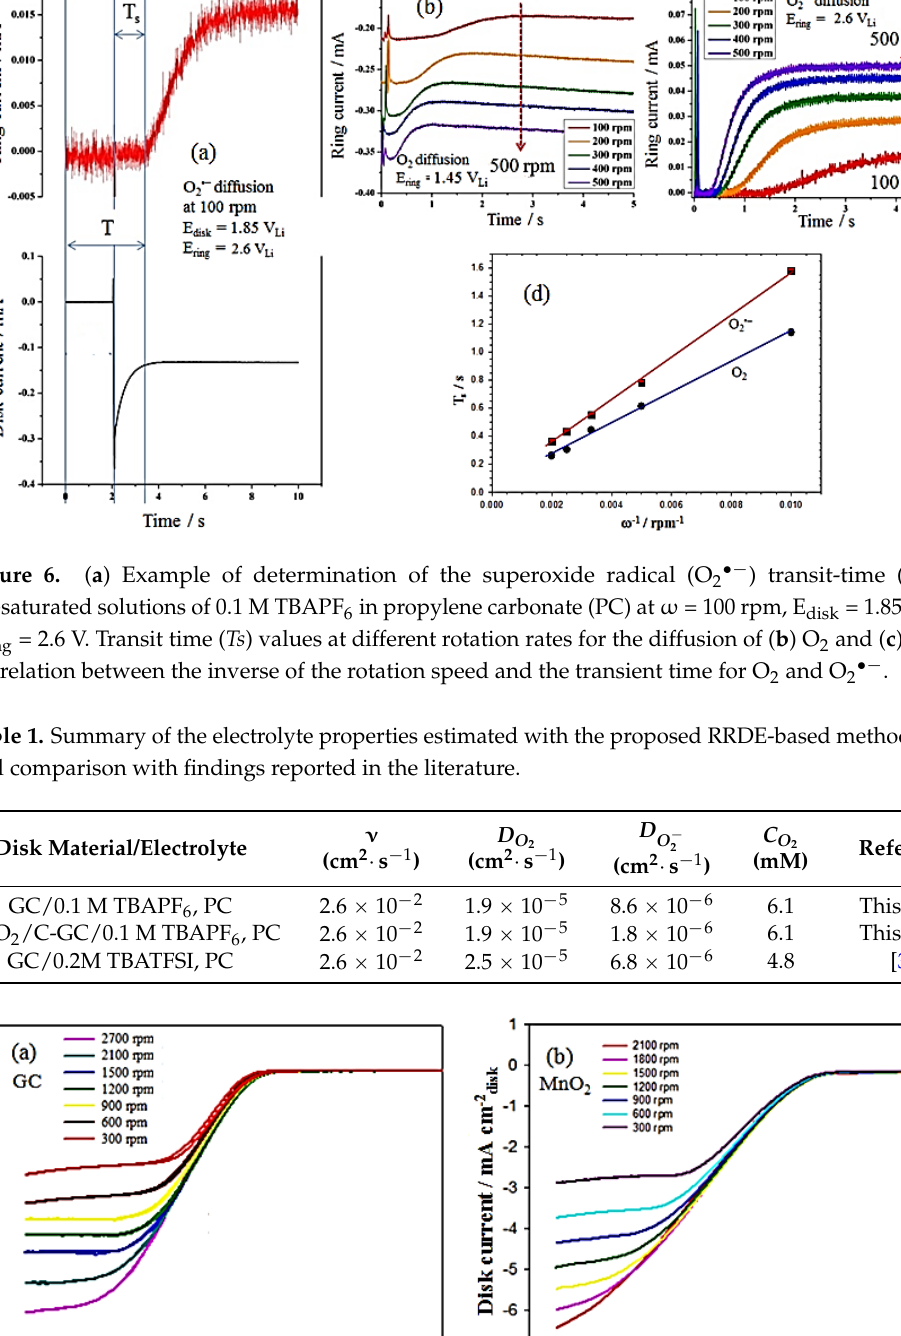
Figure 7. ( a ) Steady-state CV curves of a glassy carbon rotating disk electrode (RDE) in an O 2 - saturated 0.1 M TBAPF 6 /PC solution at a scan rate of 50 mV/s between 1.5 and 2.8 V Li with different rotation rates. The insert is the Koutecky–Levich plot derived from the disc current values at 1.50 V Li ; ( b ) steady-state CV curves of a MnO 2 /C RDE in an O 2 -saturated 0.1 M TBAPF 6 /PC solution at a scan rate of 50 mV/s between 1.2 and 2.8 V Li with different rotation rates.